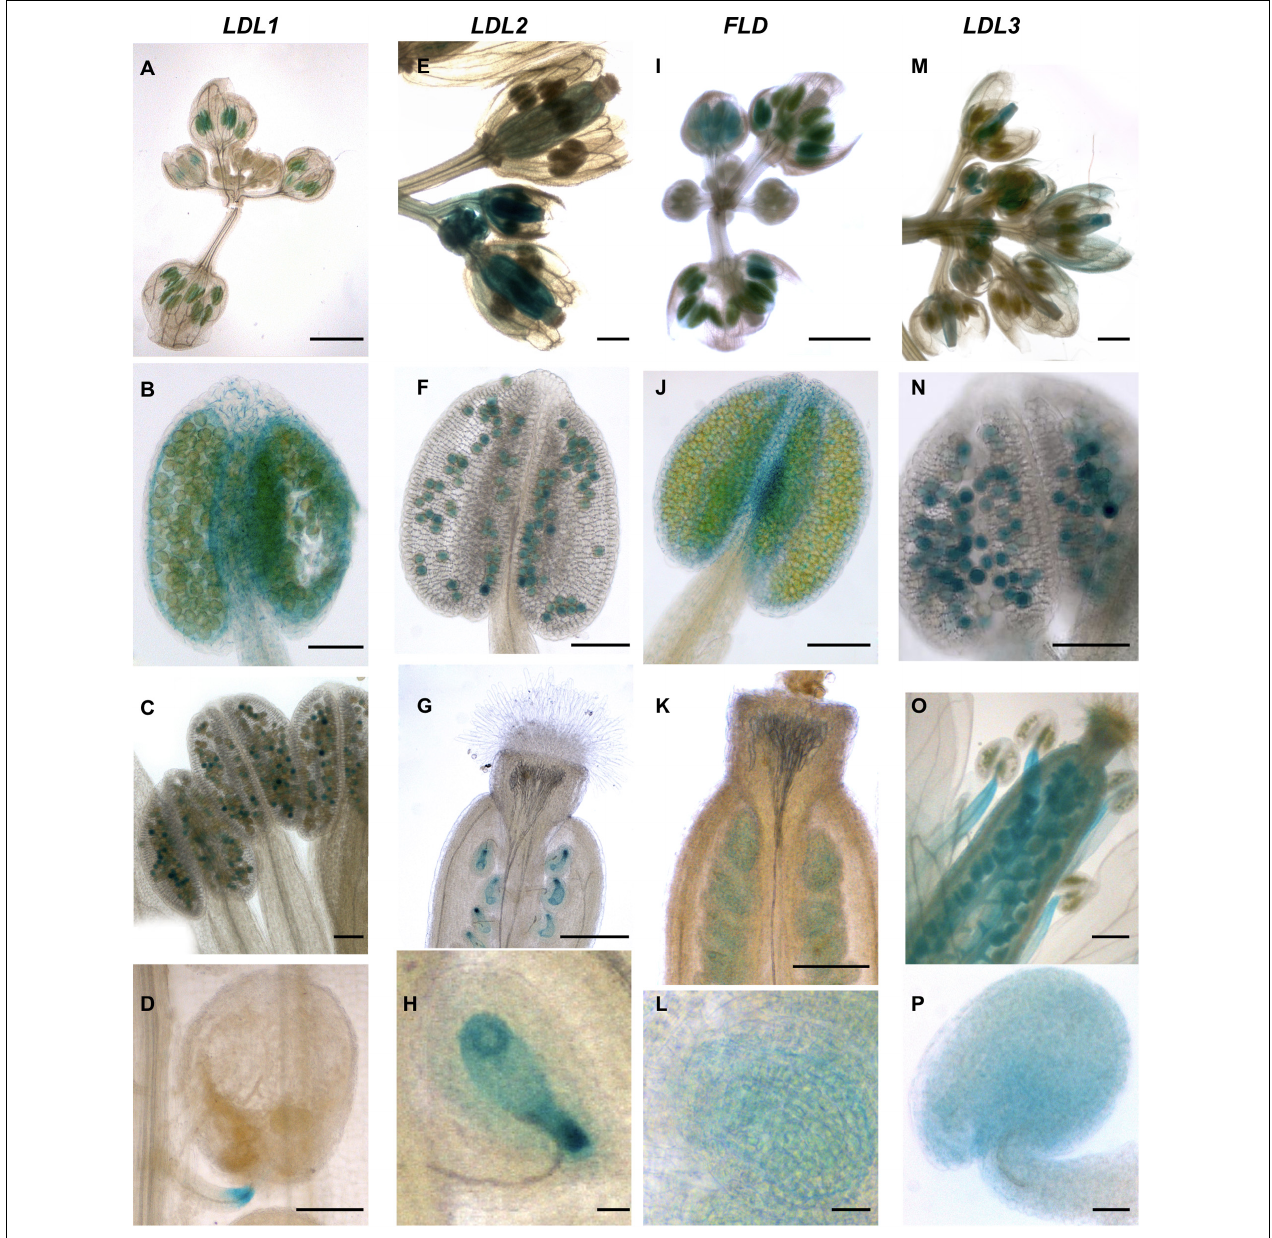
FIGURE 5 | Promoter activity of Arabidopsis LDL / FLD genes during reproductive development. Histochemical GUS staining of LDL/FLD::GFP-GUS Arabidopsis transgenic plants in inflorescences is shown. Bars indicate 1 mm in (A,E,G,I,K,M,O) , 100 µ m in (B–D,F,J,N) , and 20 µ m in (H,L,P)